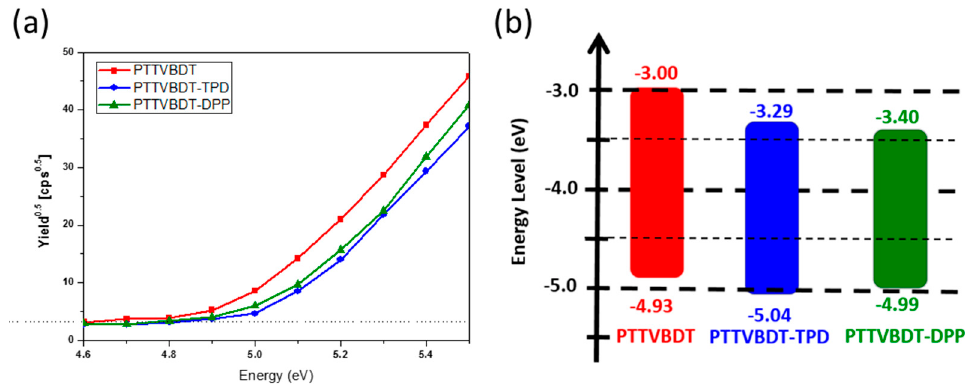
Figure 5. ( a ) Work function of polymer thin films determined by photoelectron emission; ( b ) Energy diagram of PTTVBDT, PTTVBDT-TPD, and PTTVBDT-DPP.